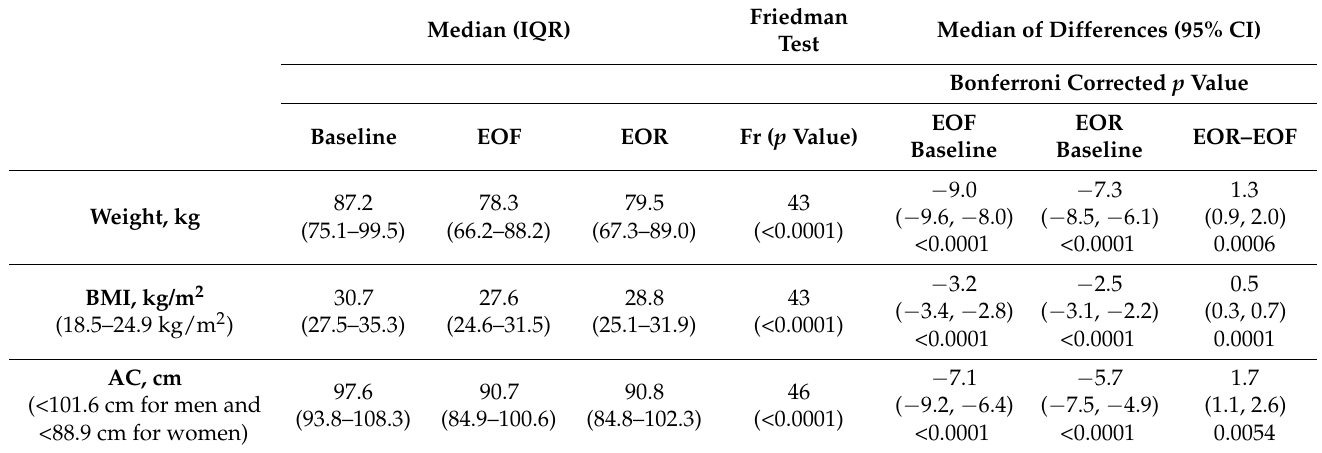
Table 1. The effects of fasting and refeeding on cardiometabolic markers. Median ( IQR )